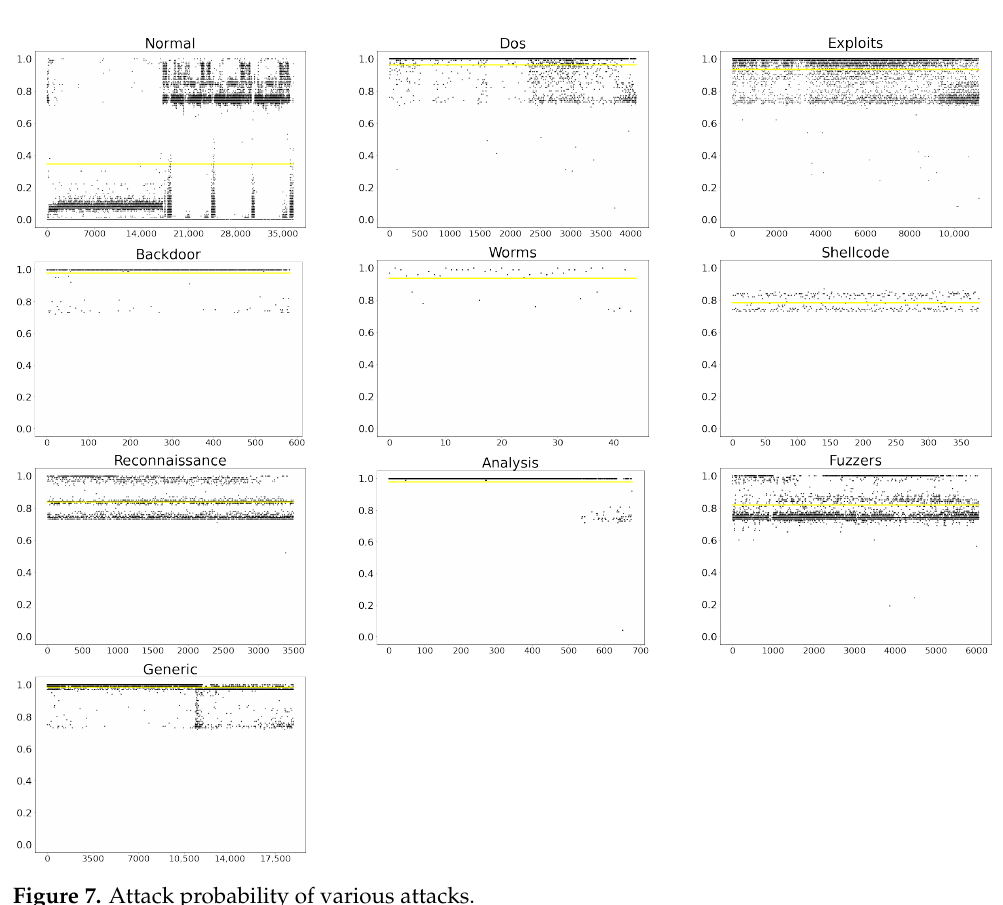
Figure 7. Attack probability of various